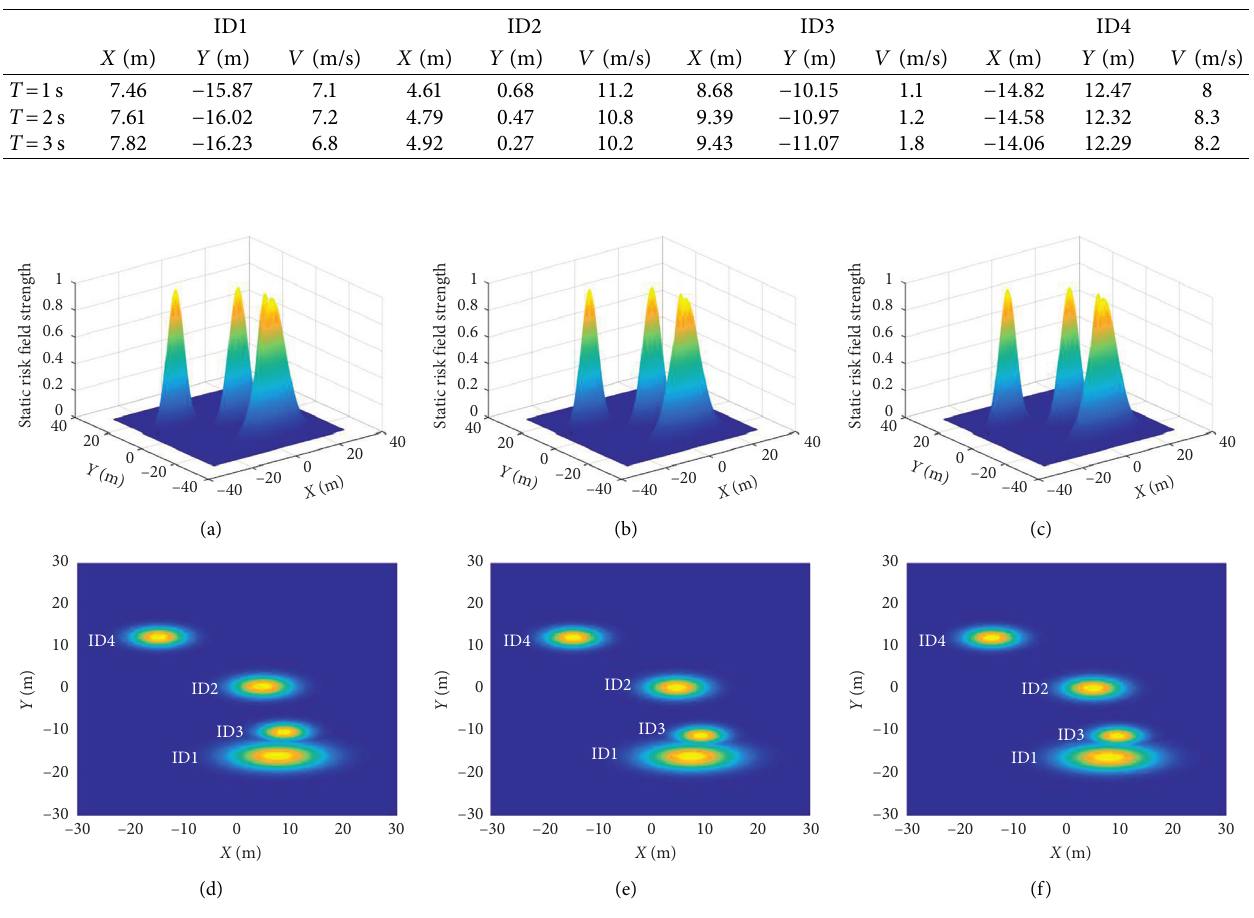
Figure 11: The changes of static risk field prediction. (a) T � 1s. (b) T � 2s. (c) T � 3s. (d) T � 1s. (e) T � 2s. (f) T �